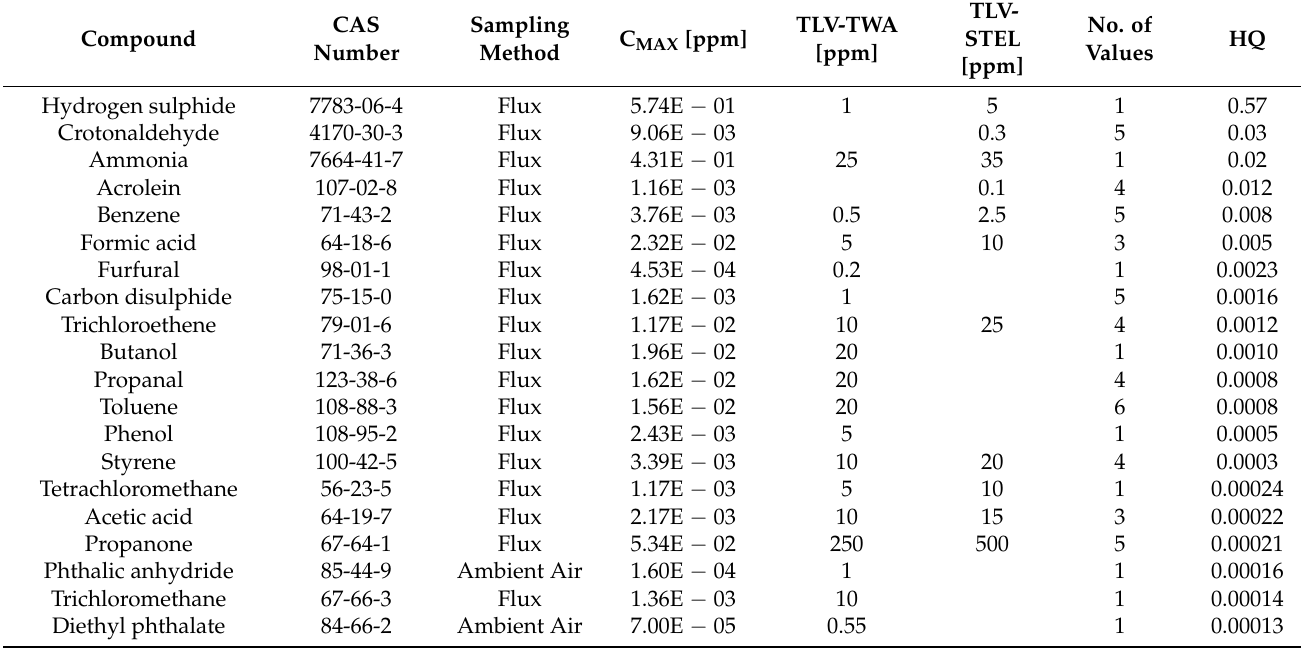
Table 4. Maximum concentration, number of values observed in the literature, TLV and HQ values relevant to the most critical compounds found in temporarily covered landfill surface emission.